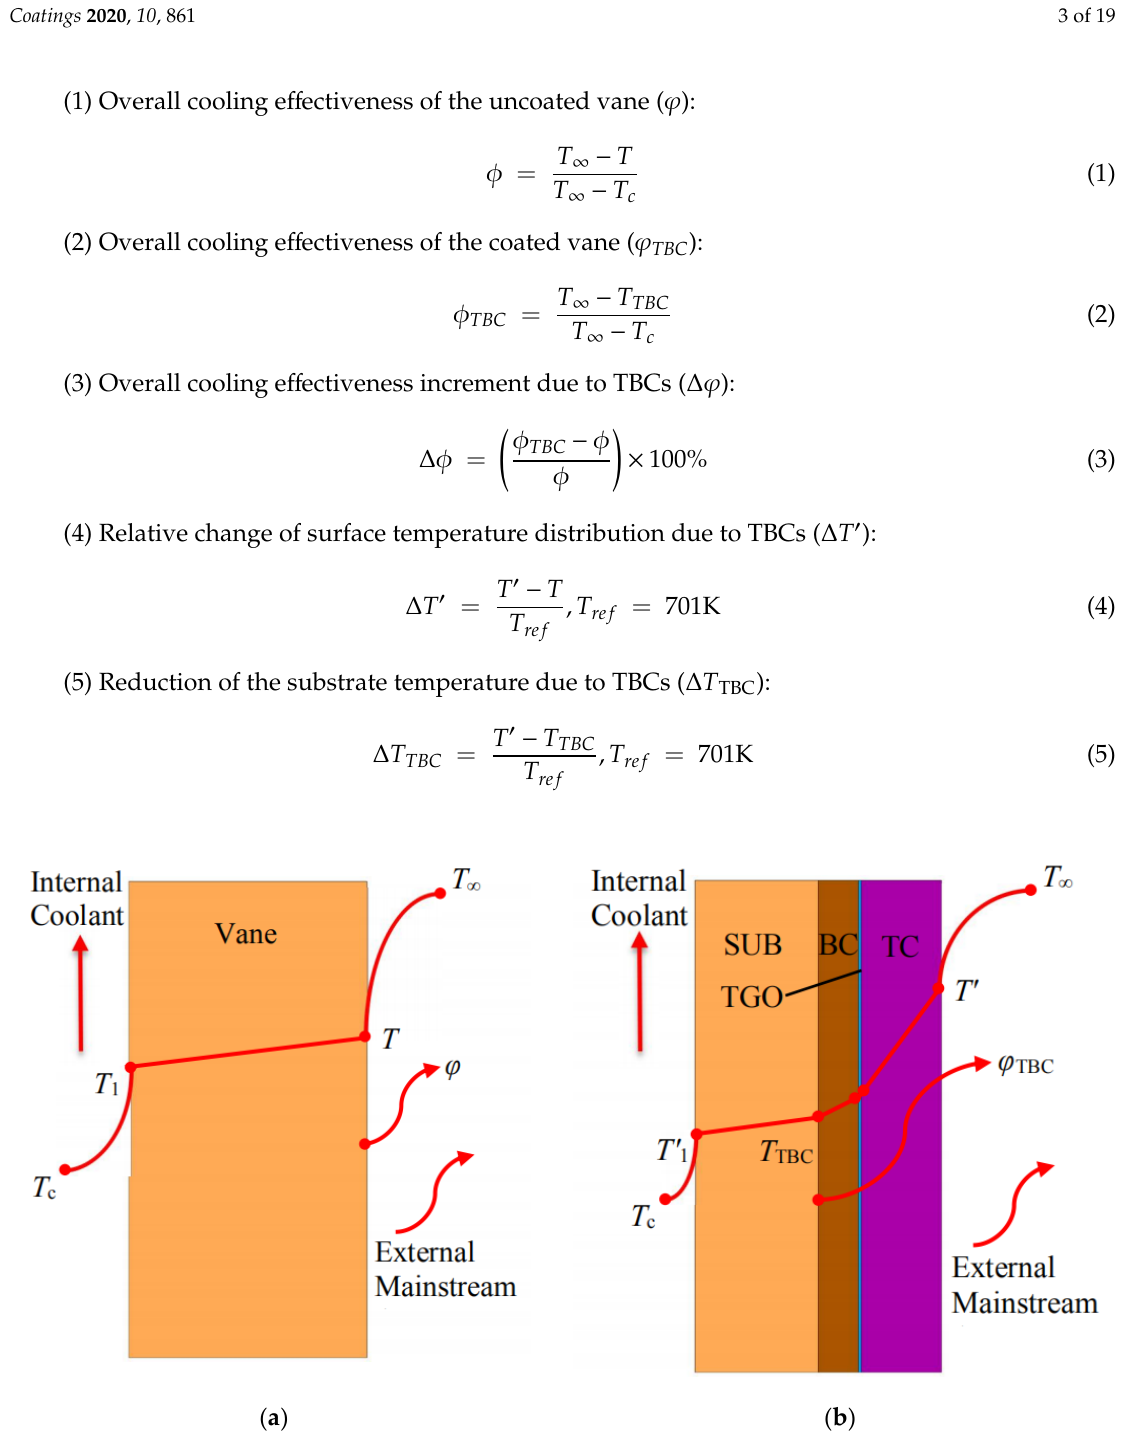
Figure 1. Thermal parameters definition. ( a ) uncoated vane; ( b ) coated vane. Table 1. Material properties [13,17,18].